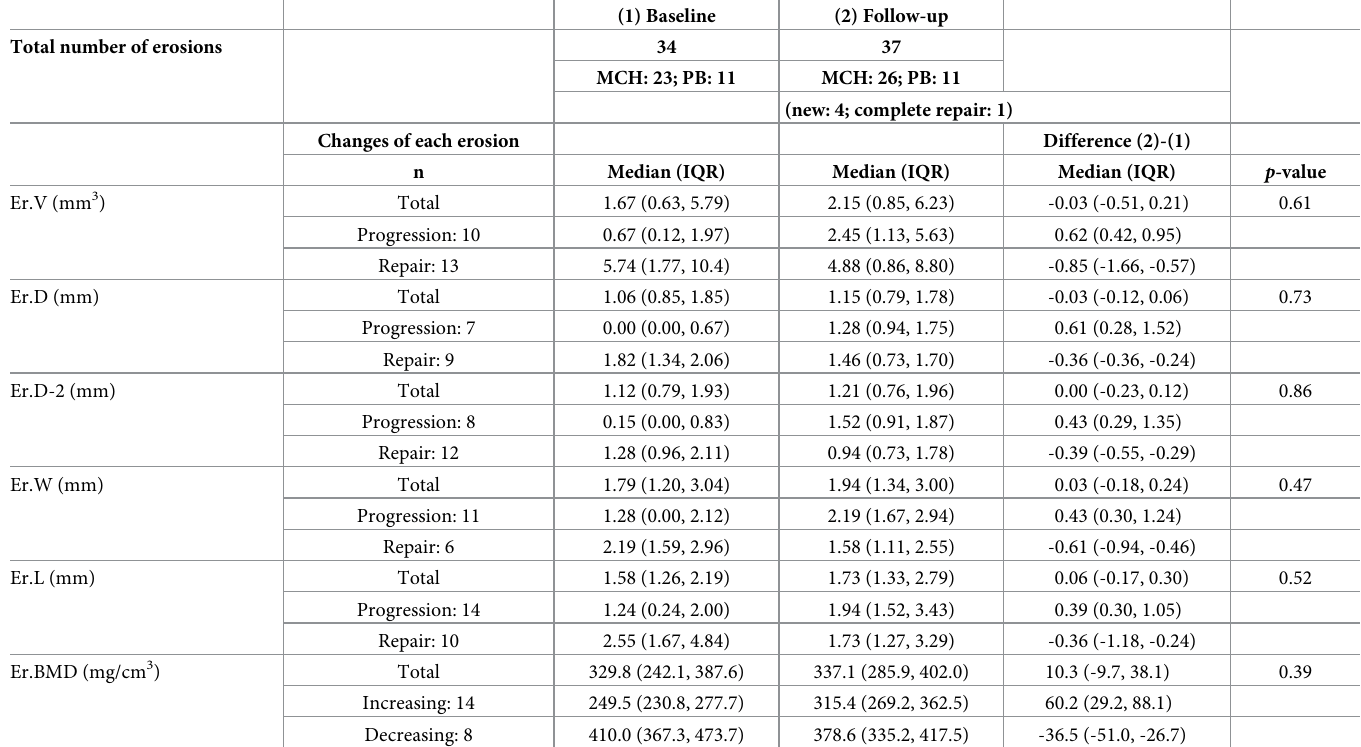
Table 3. Longitudinal changes in erosion parameters for patients with RA (n = 26).